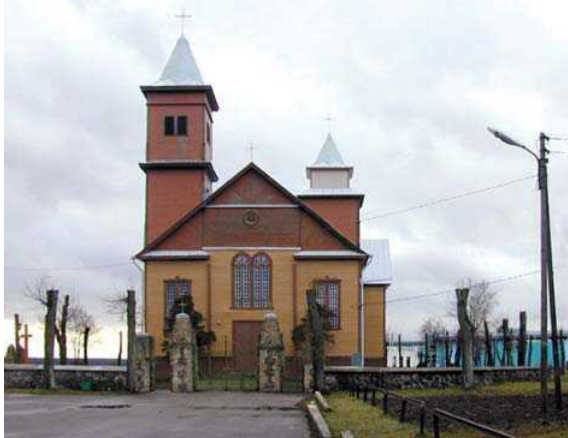
Fig 1. Church of St Mary, Good Advisor, in